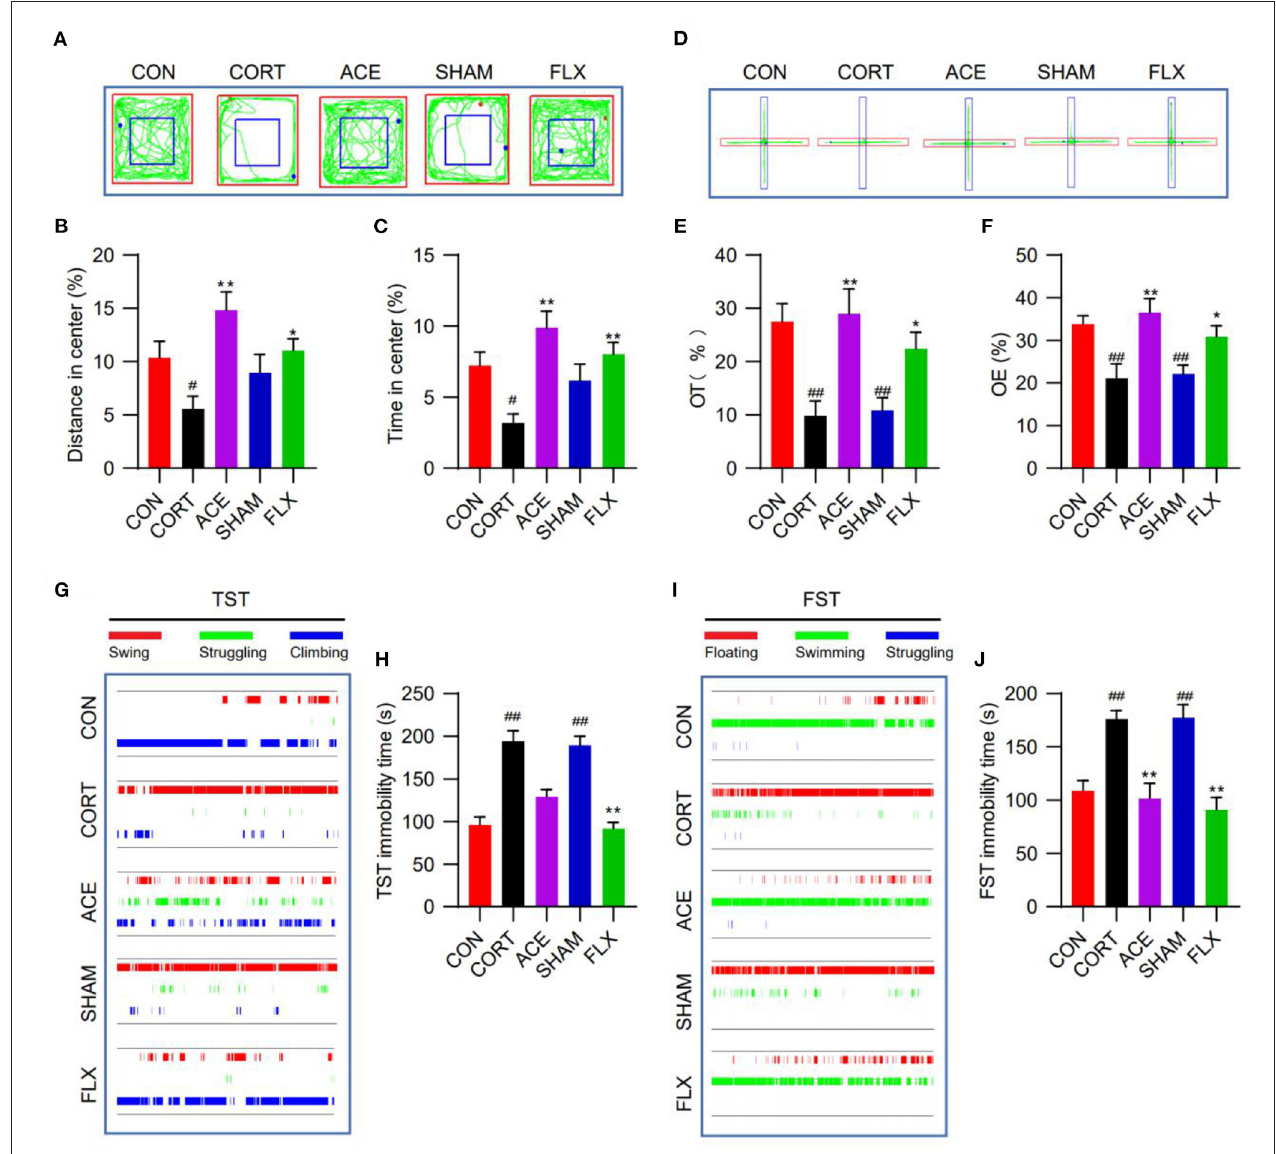
FIGURE 2 | Effect of ACE on the depression-like behavioral deficits of mice. (A) The representative trajectory diagrams of mice in OFT. (B) ACE significantly increased the distance in center of mice in OFT ( n = 16 per group). (C) ACE significantly increased the time in center of mice in OFT ( n = 16 per group). (D) The representative trajectory diagrams of mice in EPMT. (E) ACE significantly increased the OT% of mice in EPMT ( n = 16 per group). (F) ACE significantly increased the OE% of mice in EPMT ( n = 16 per group). (G) The representative trajectory diagrams of mice in TST. (H) ACE decreased the immobility of mice in TST to some degree without statistical significance ( n = 16 per group). (I) The representative trajectory diagrams of mice in FST. (J) ACE significantly decreased the immobility of mice in FST ( n = 16 per group). Experimental values were expressed as means ± SD. # P < 0.05 and ## P < 0.01 compared with the CON group. * P < 0.05 and ** P < 0.01 compared with the CORT